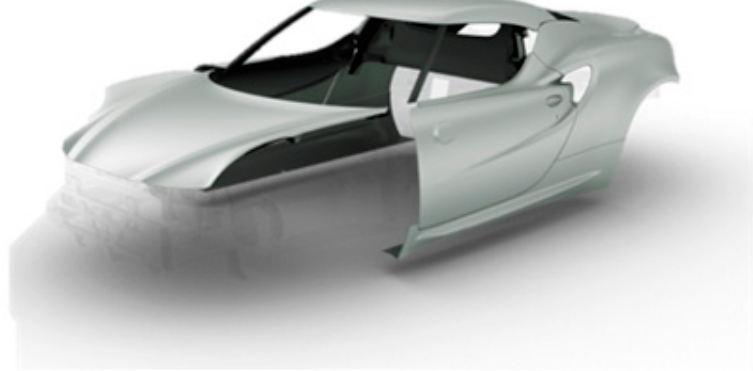
Figure 1. Fiberglass composite components of the Alfa Romeo 4C car.